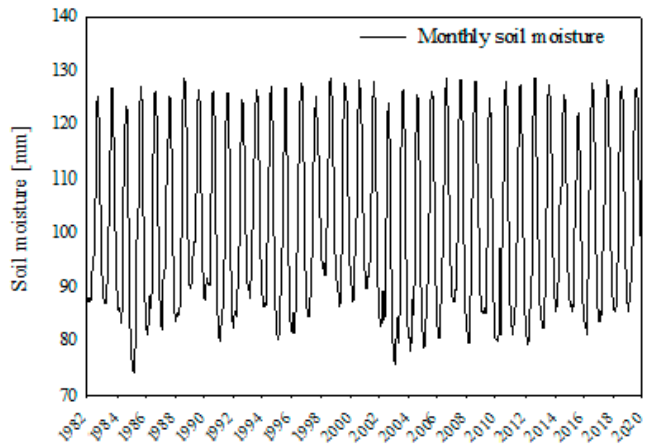
Figure A1. Rainfall.